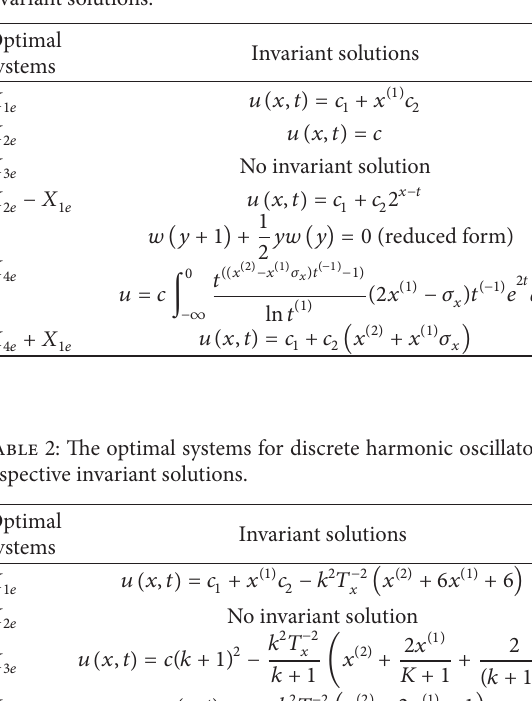
Table 1: Optimal systems for free heat equation and respective invariant solutions.